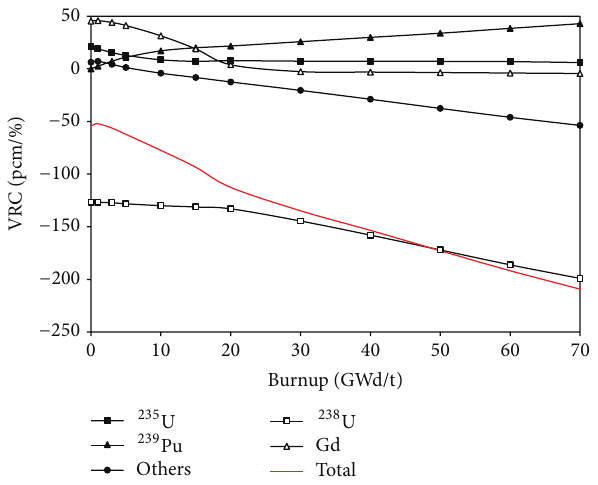
Figure 7: Thermal neutrons fractions for innovative assemblies’